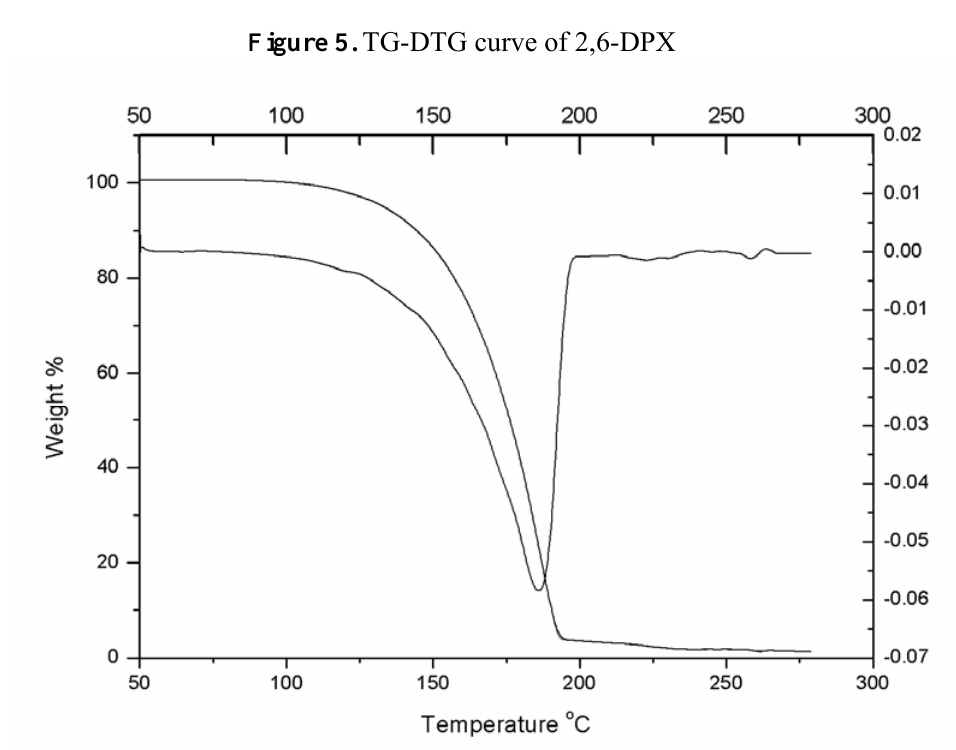
Figure 5. TG-DTG curve of